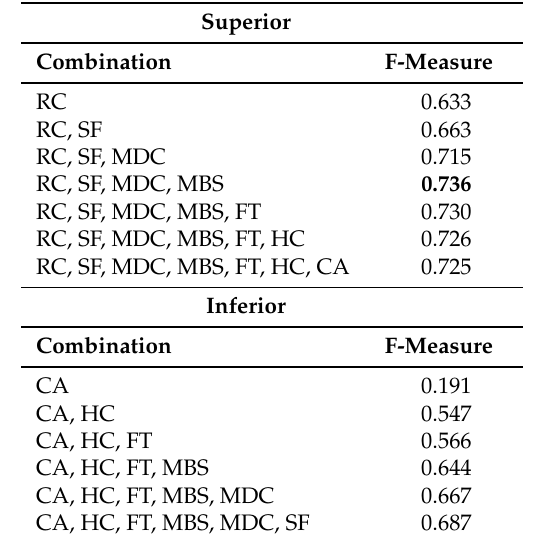
Table 2. Performance comparison of various saliency models combinations. The combination that includes the RC, SF, MDC, and MBS models obtains the better performance in F-measure